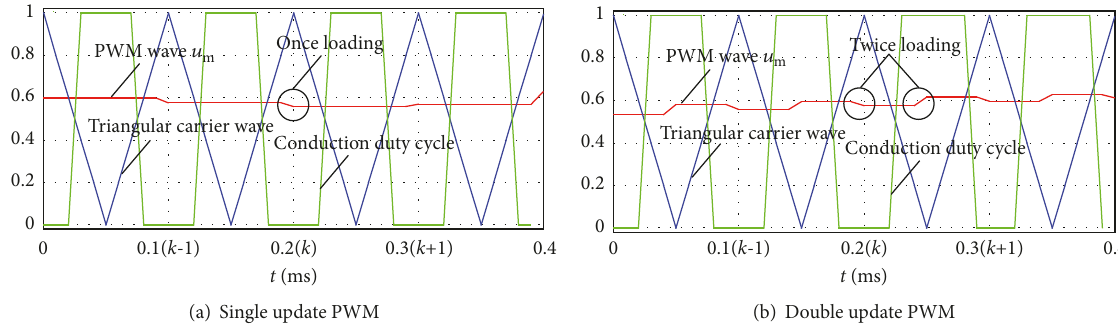
Figure 13: The simulation waveforms of the modulation wave and triangular carrier wave.